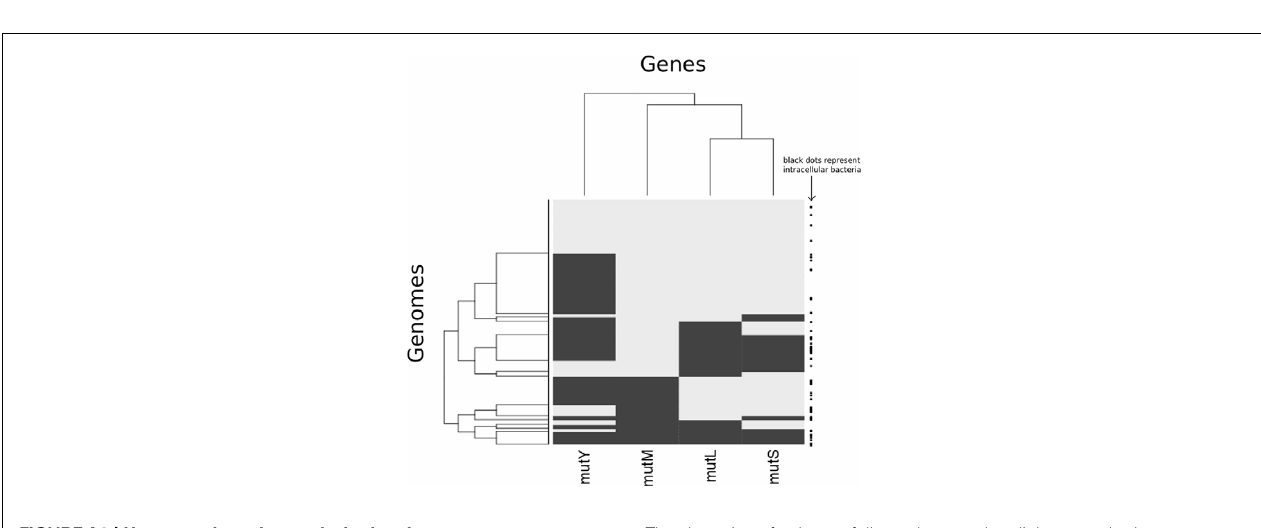
The clustering of columns follows the complete linkage method, as implemented in the R statistical package.The right hand side of the plot displays whether a genome belongs to a bacterium that is intracellular (black